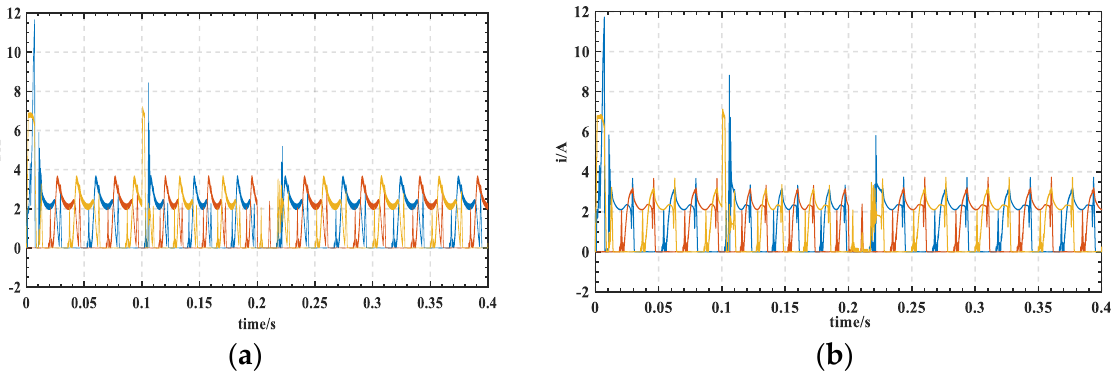
Figure 8. Comparison of current: ( a ) PID control system current and ( b ) FNN control system cur- rent.